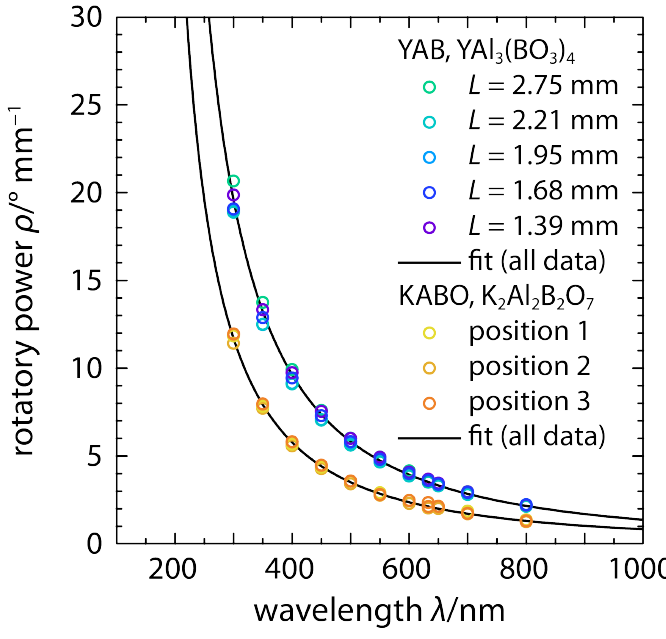
Figure 4. Optical rotatory dispersion of YAB (YAl 3 (BO 3 ) 4 ) and KABO (K 2 Al 2 B 2 O 7 ). For YAB, rotatory powers were measured on the same domain for five different optical path lengths (see also Figure 3a). For KABO, rotatory powers were measured at three different locations on the same crystal